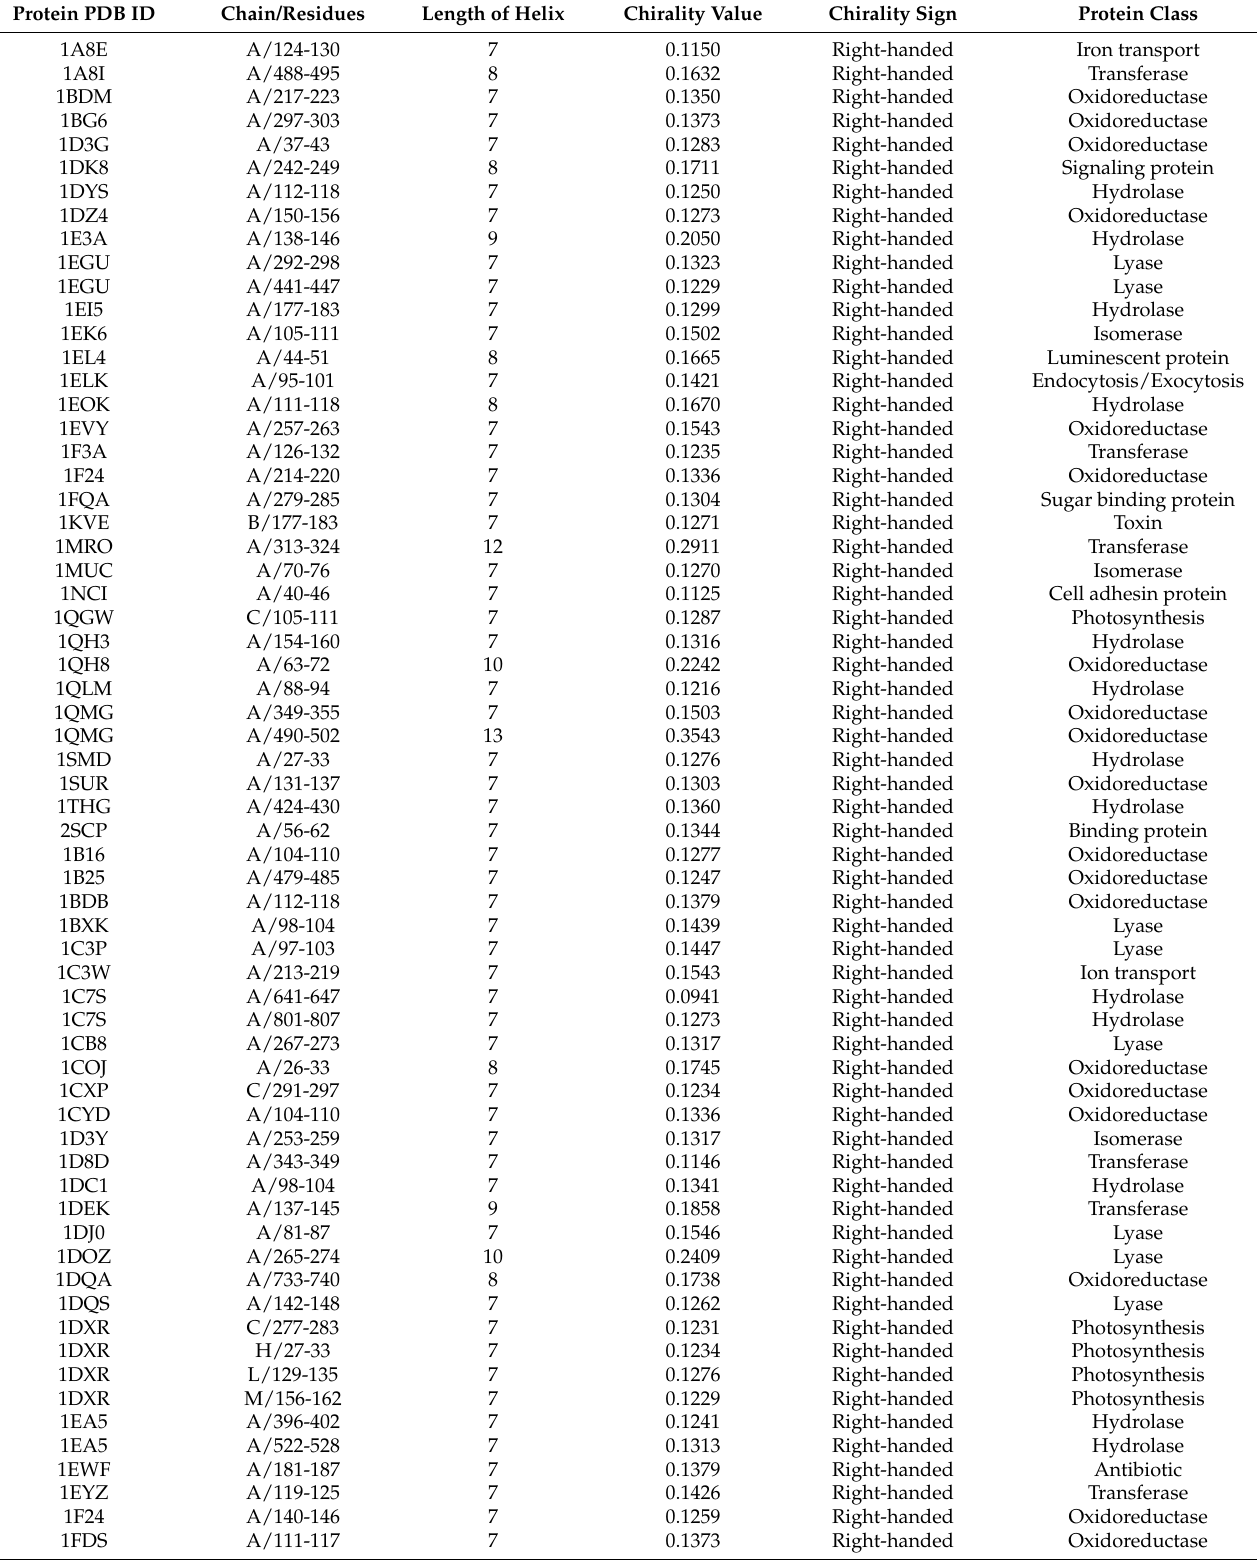
Table A1. The calculated parameters of π